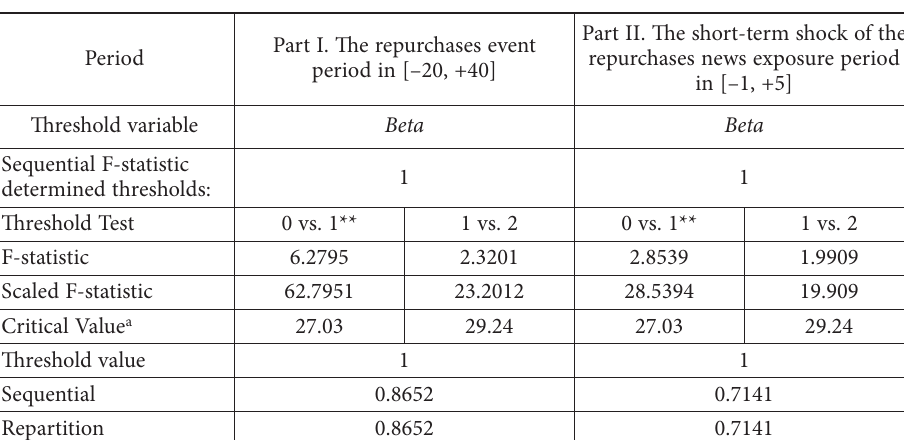
Table 4. The structural change tests of pre-repurchase beta for the relationship between investor behav- iors, market factors and repurchase stock price